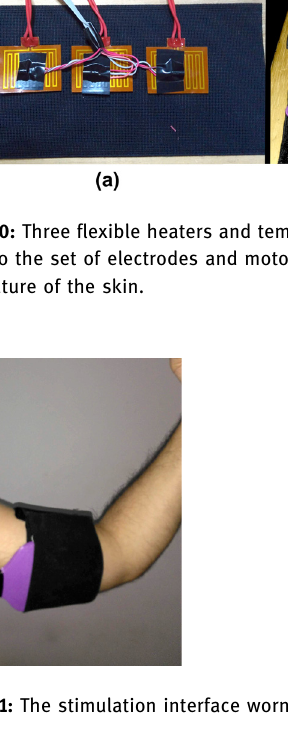
Figure 12: Block diagram of the hardware for controlling the